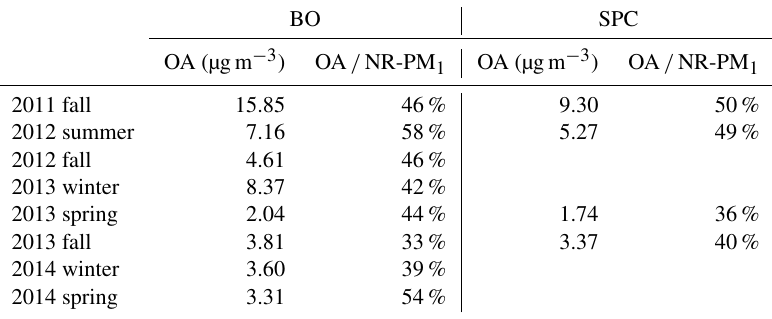
Table 1. Average organic aerosol (OA) concentrations and their relative contributions to the NR-PM 1 mass measured by the HR-ToF-AMS within each